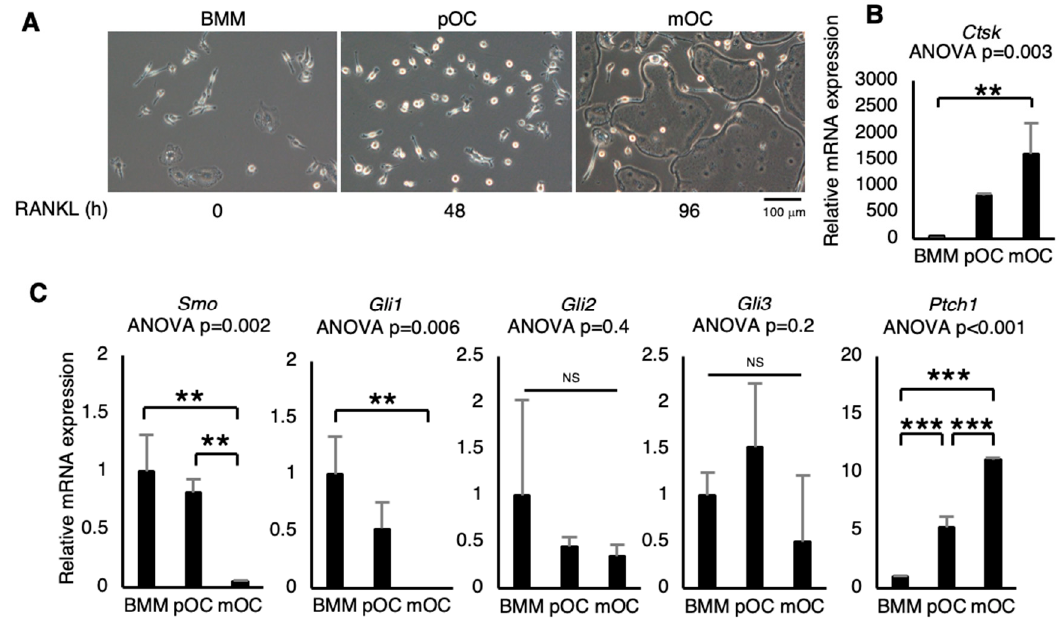
Figure 1. Changes in expression of Hedgehog (Hh) signaling-related genes during